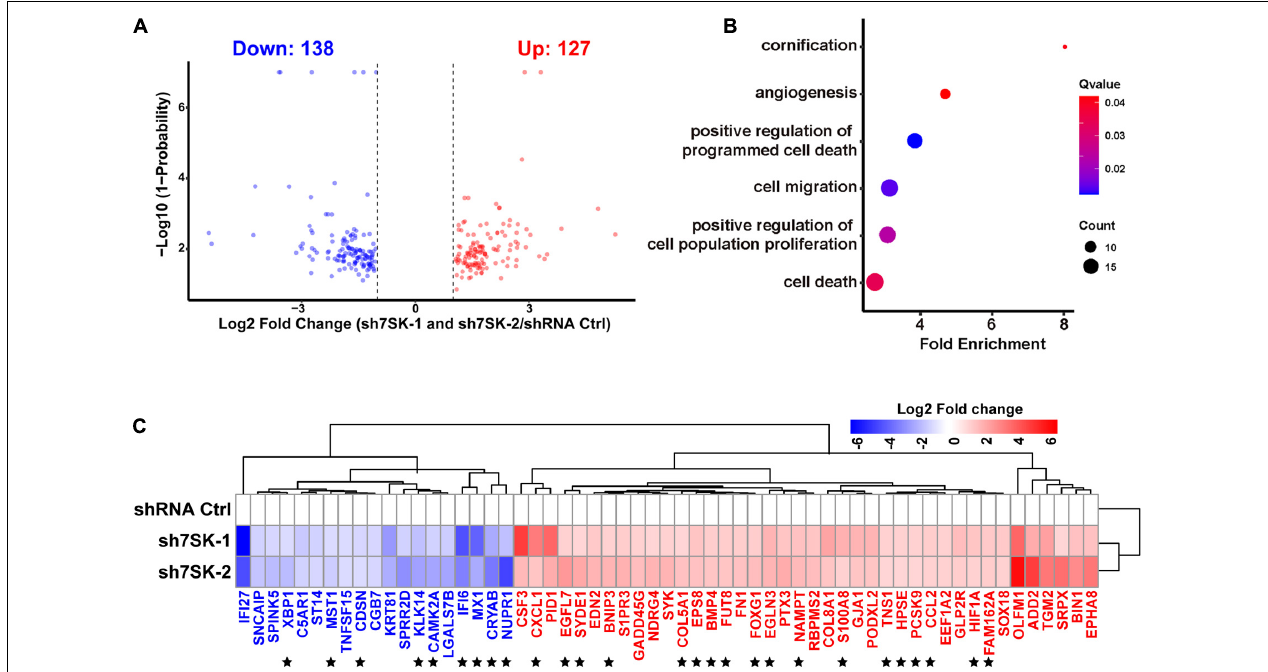
FIGURE 3 | 7SK regulates genes that are involved in tumor progression. (A) Volcano plot of commonly regulated genes identified from sh7SK-1 and sh7SK-2 RNA-seq compared with shRNA Ctrl. (B) Biological processes related to tumor progression and significantly enriched by Gene Ontology (GO) analysis using 7SK regulated genes from (A) . (C) The Log 2 fold changes of the genes that are identified from (B) are illustrated on a heat map. (cid:70) , 27 genes that are further identified as 7SK directly associated genes shown in Figure 4 . Blue: down-regulated genes in the presence of 7SK shRNAs; red: up-regulated genes in the presence of 7SK shRNAs, n =